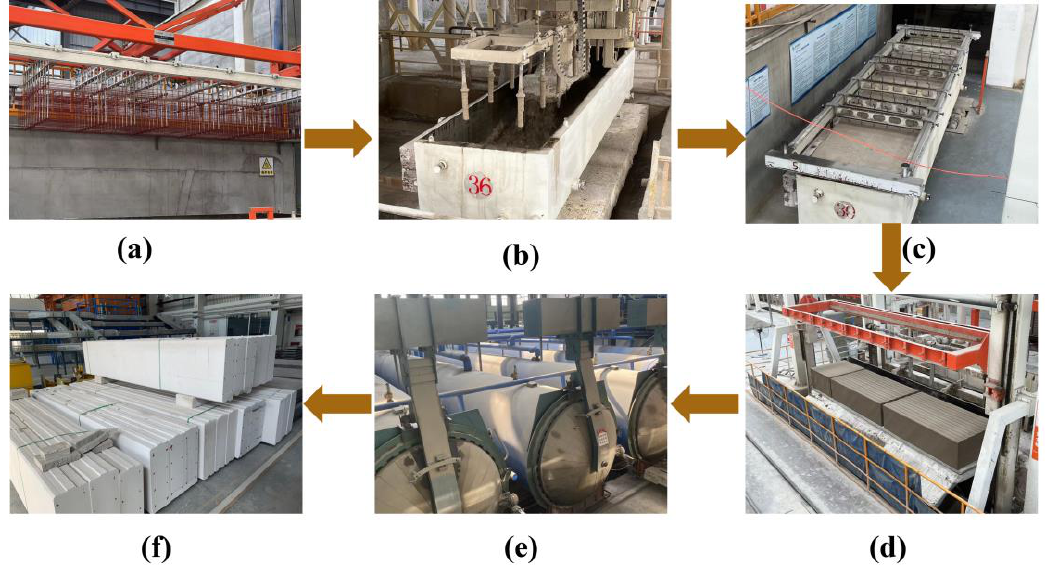
Figure 7. Images showing the production process of AAC wall panels: ( a ) tied rebar is coated with anti-corrosion solution; ( b ) concrete filling; ( c ) concrete setting; ( d ) concrete cutting; ( e ) concrete subjected to pressurized aeration; ( f ) formation of the AAC panel. Table 3. Technical specifications of the AAC panel.